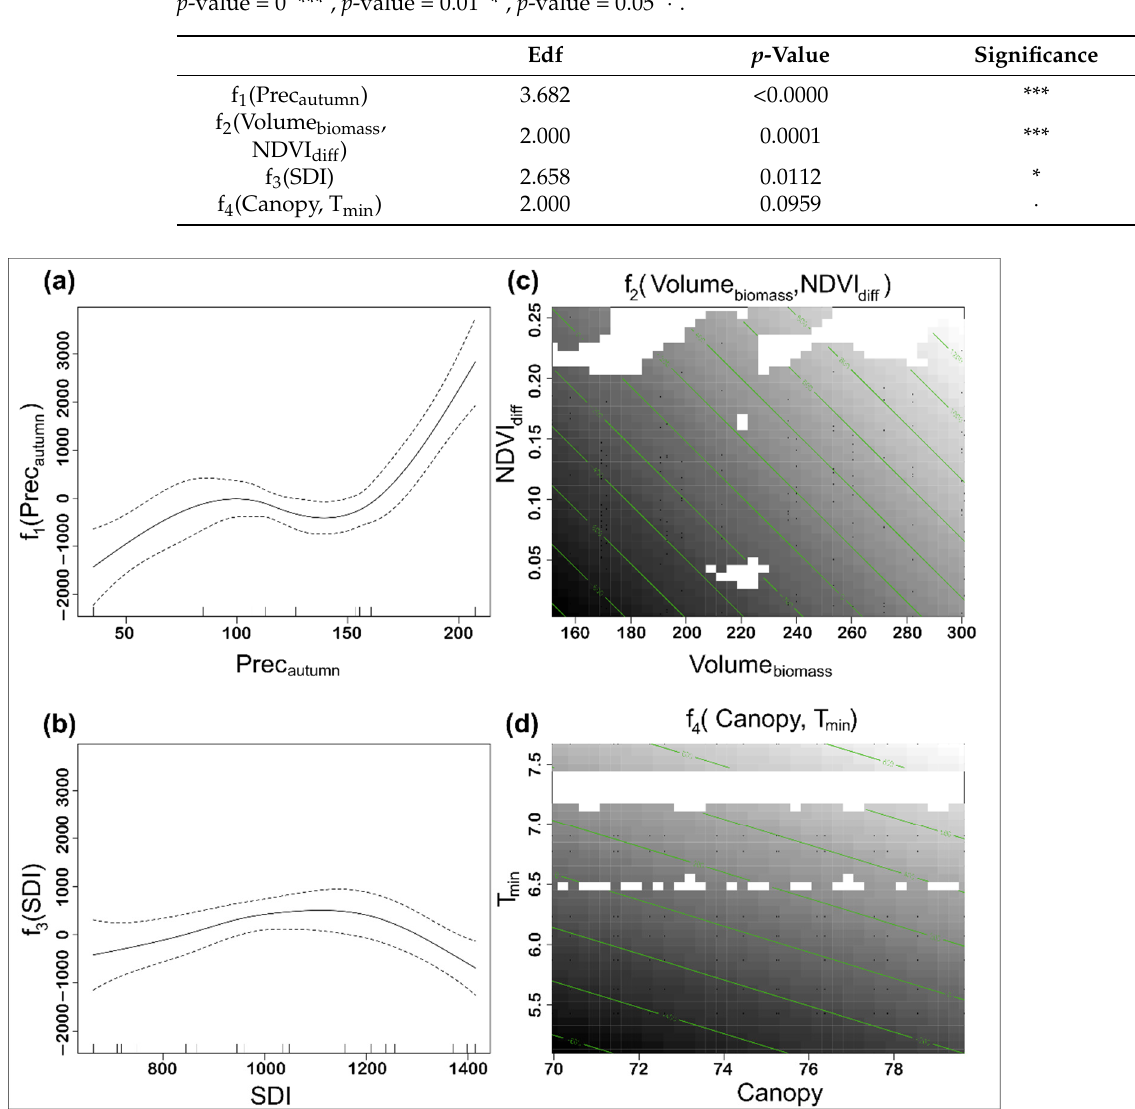
Figure 7. Model predictions for all mushroom yields. Yield total ( Y -axis) versus Volume biomass ( X -axis) are shown for five different NDVI diff values and SDI values of 650, 950, and 1250.